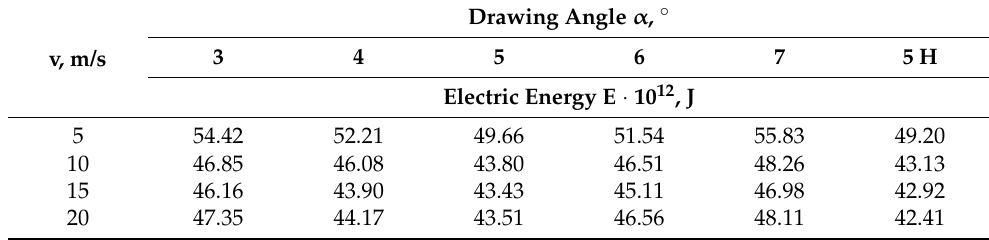
Table 2. The total amount of electric energy E required to manufacture 100,000 tons of 2.2 mm wire, depending on the drawing technology used, where α —drawing angle, H—hydrodynamic dies, v—drawing